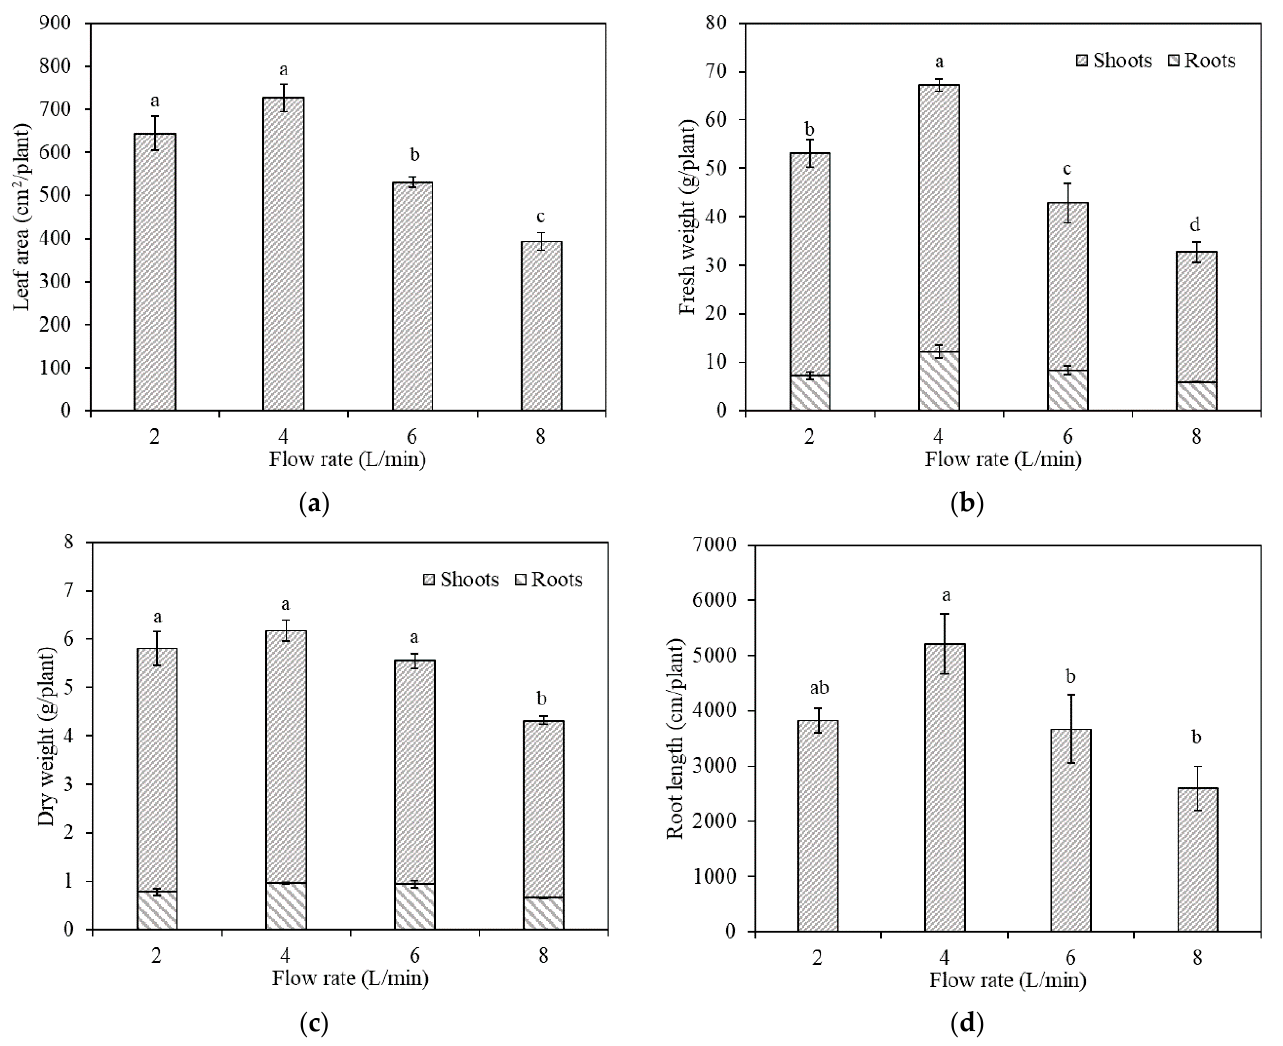
Figure 1. Growth parameters of the plants growth under different flow rates in this study. ( a ) Leaf area; ( b ) fresh weight; ( c ) dry weight; ( d ) root length. There were significant differences in the bars marked with different letters ( p < 0.05). Data are expressed as means ± standard error ( n = 4).